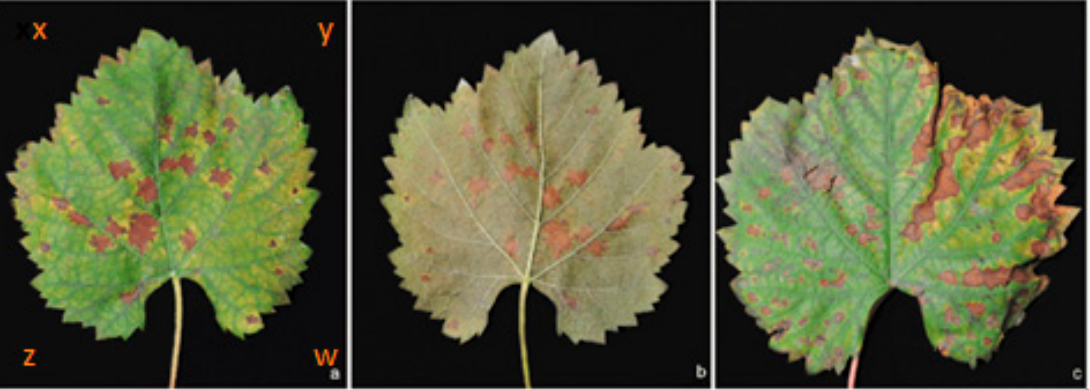
Figure 6. ( a , c ) Crystals on the upper surface of the leaf; ( b ) crystals on the lower surface of the leaf.